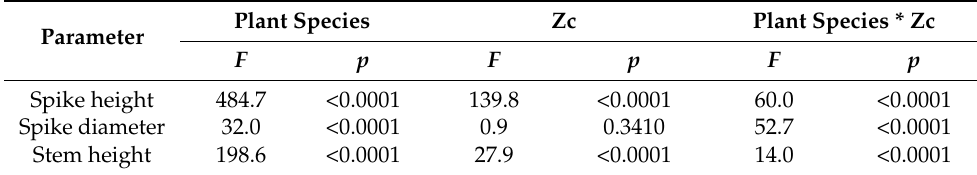
Table 3. Effects of the plant species characteristics and pollution level expressed by the integral